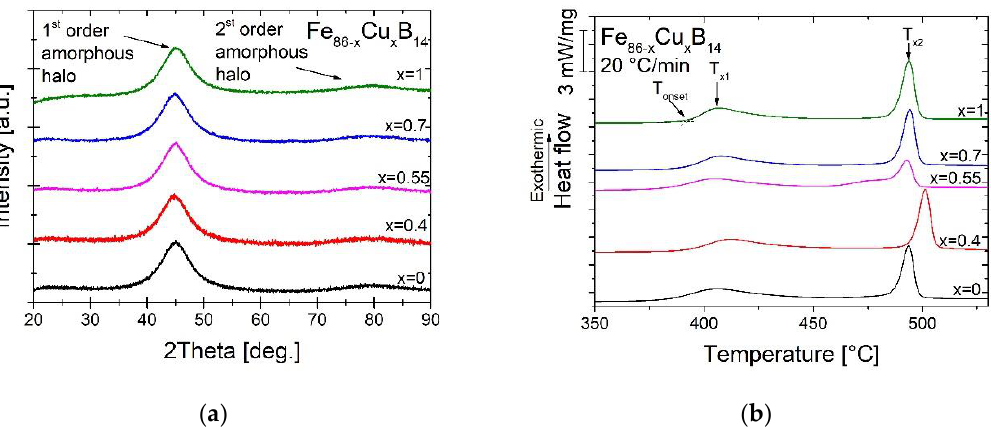
Figure 2. XRD patterns ( a ) and differential scanning calorimetry (DSC) signals ( b ) for as-spun metallic glasses. Table 2. The activation energy E a calculated from the T x1 temperatures with